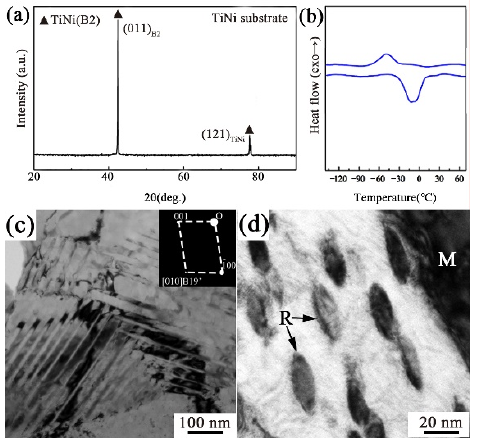
Figure 2. ( a ) XRD patterns of as-deposited Ti 49.2 Ni 50.8 ; ( b ) DSC curve of as-deposited Ti 49.2 Ni 50.8 ; ( c ) Bright-field TEM image showed that there were a significant amount of martensite lath in the sample; ( d ) Lenticular R phase is densely distributed around martensite.